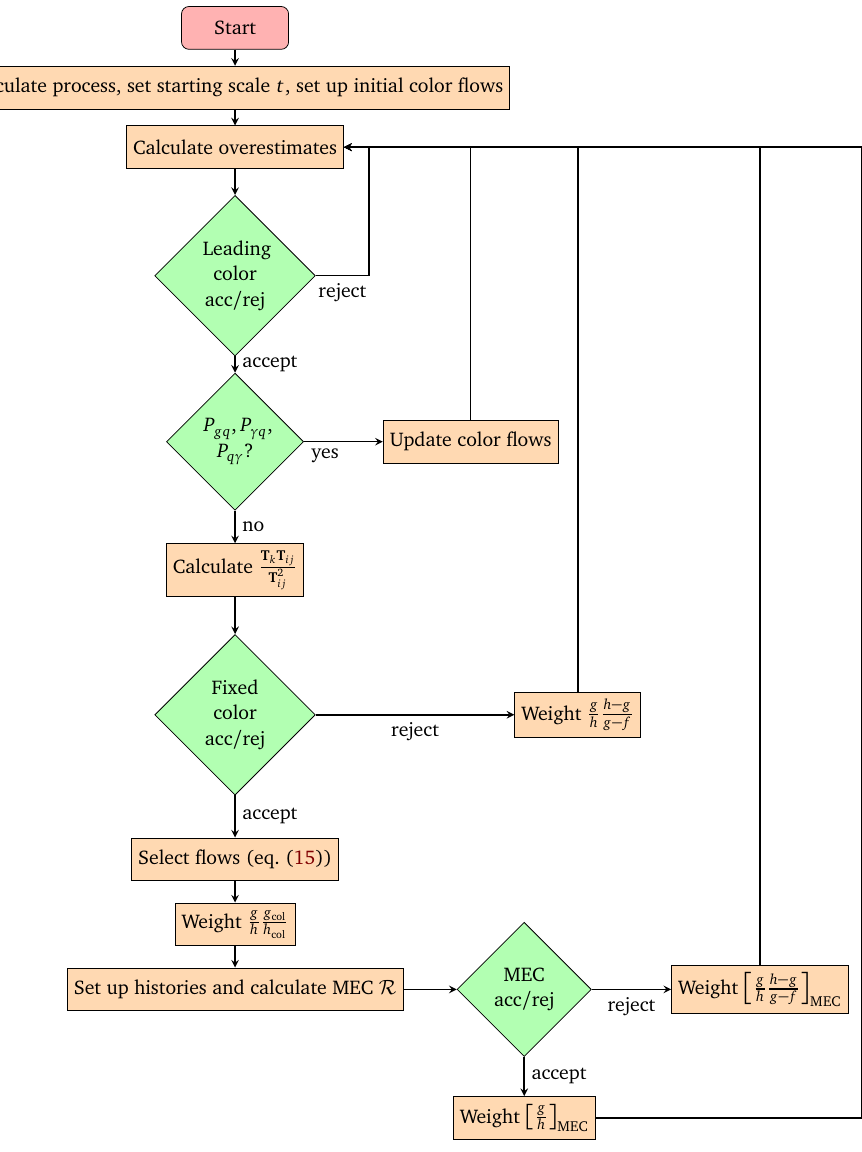
Figure 10: Multiple accept / reject steps are iterated to implement the fixed color correction to the leading color shower, and the kinematic matrix element correction to the fixed color shower. The treatment of the fixed color cut t cut-off t are omitted to make the flow clearer. This flow assumes that the generated 0 emissions are above t cut FC